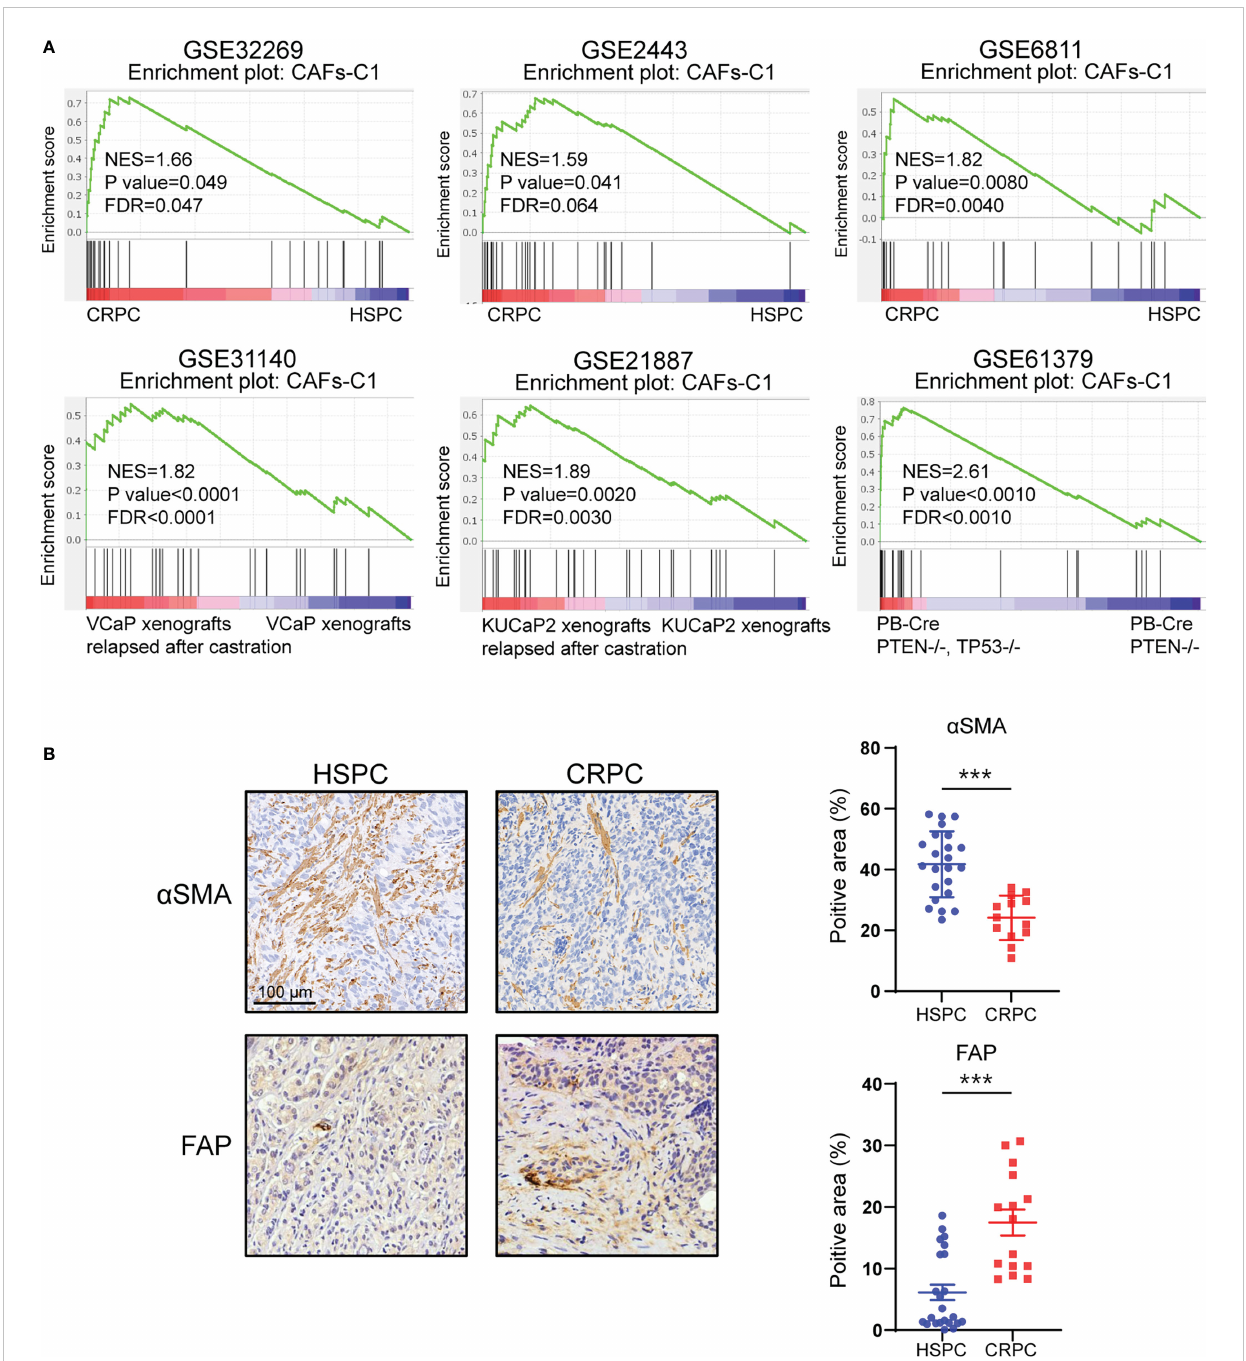
FIGURE 5 CAFs subtype signatures in bulk-sequencing pro fi les. (A) GSEA analysis for CAFs-C1 signature between HSPC versus CRPC samples. (B) Representative immunohistochemistry images and quanti fi cations of a SMA and FAP in HSPC and CRPC sample sections. Scale bars, 100 m m. Data shown as mean ± SD.